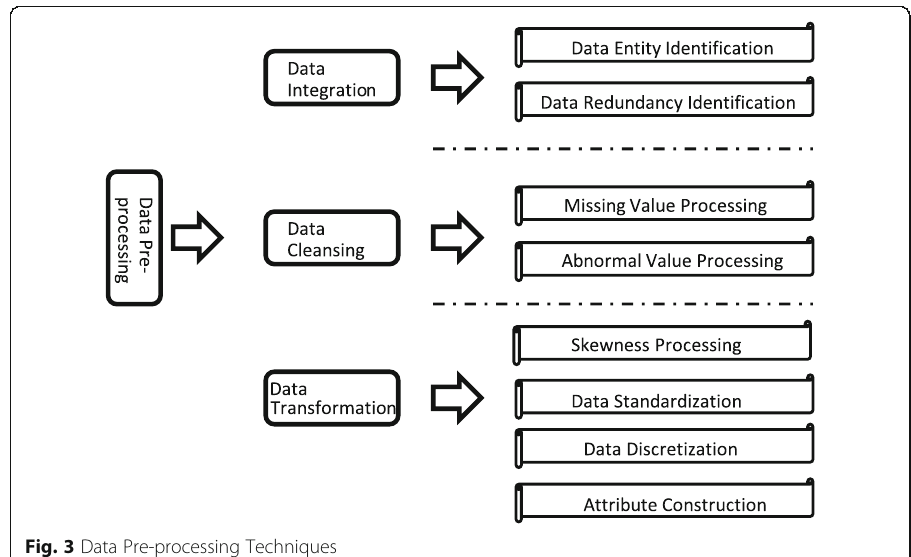
Fig. 3 Data Pre-processing